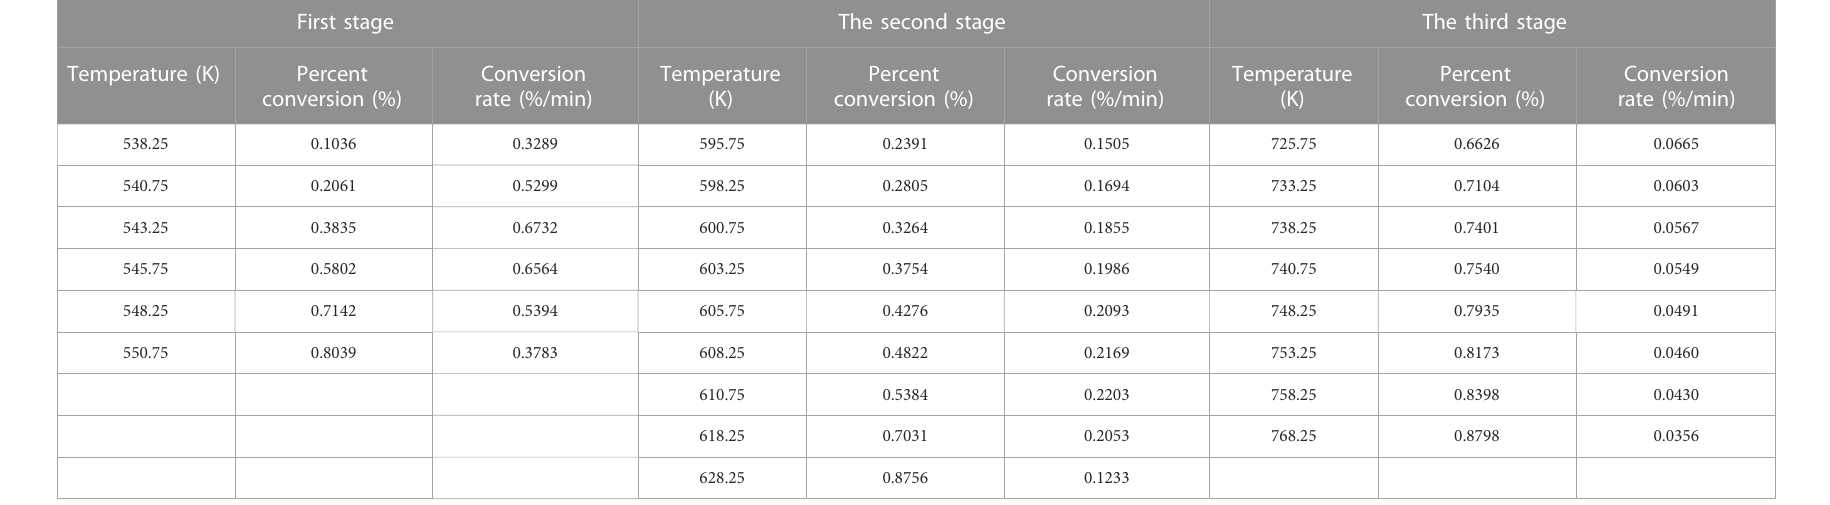
First stage The second stage The third